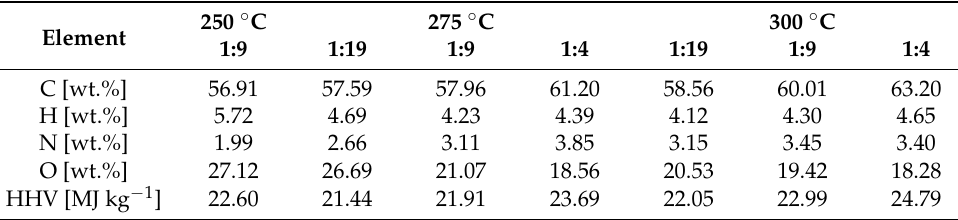
Table 4. Elemental composition of biochars obtained from blackcurrant pomace. Element